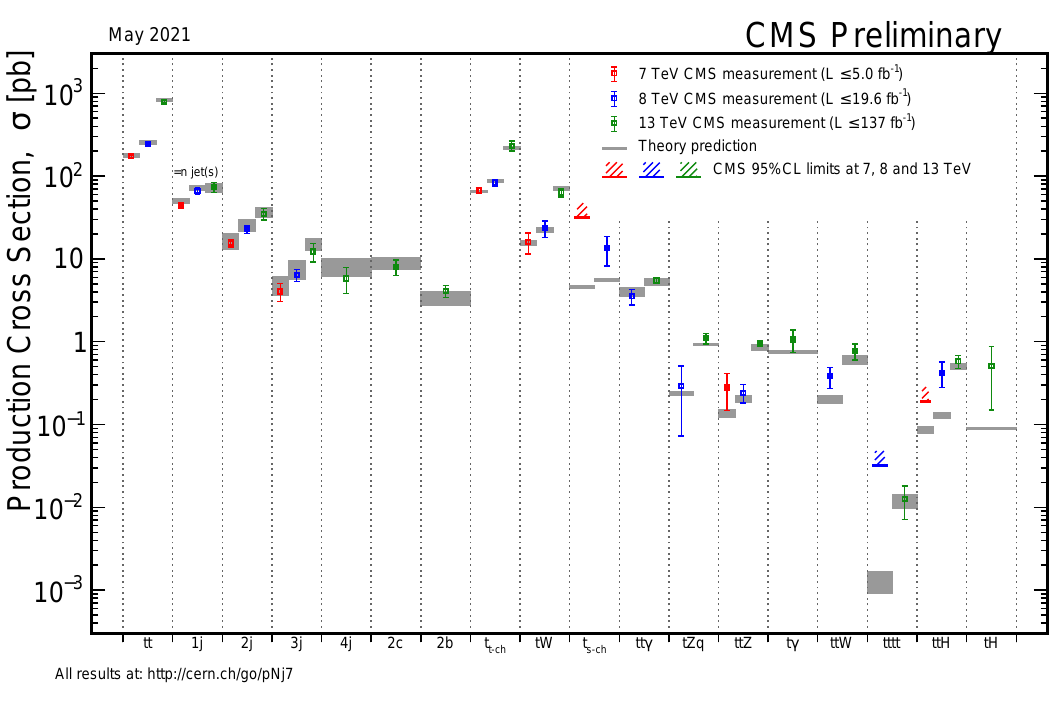
Figure 1: Top quark production cross section at various center-of-mass energies mea- sured by the CMS experiment. The measurements are performed for the production of single t , t ¯ t , t ¯ t + jets, t + X, t ¯ t + X, t ¯ tt ¯ t , etc. Among these, a few of them are new at 13 TeV whereas a few of them are still being studied. There is a good agreement between the predicted and measured values within the